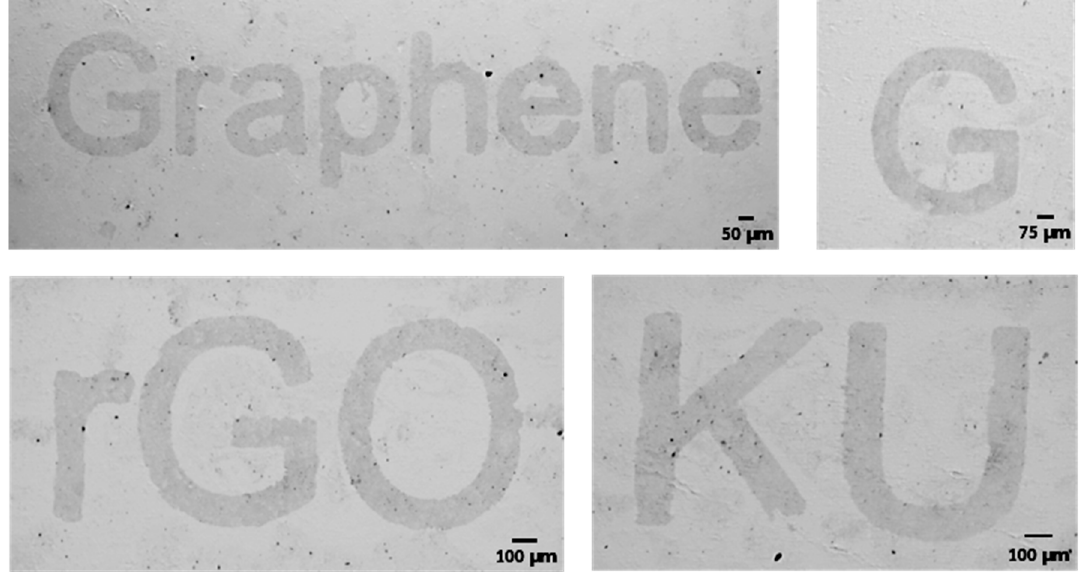
Figure 3. Optical microscopic images of the micro-patterns produced using the pattern methodology proposed in this